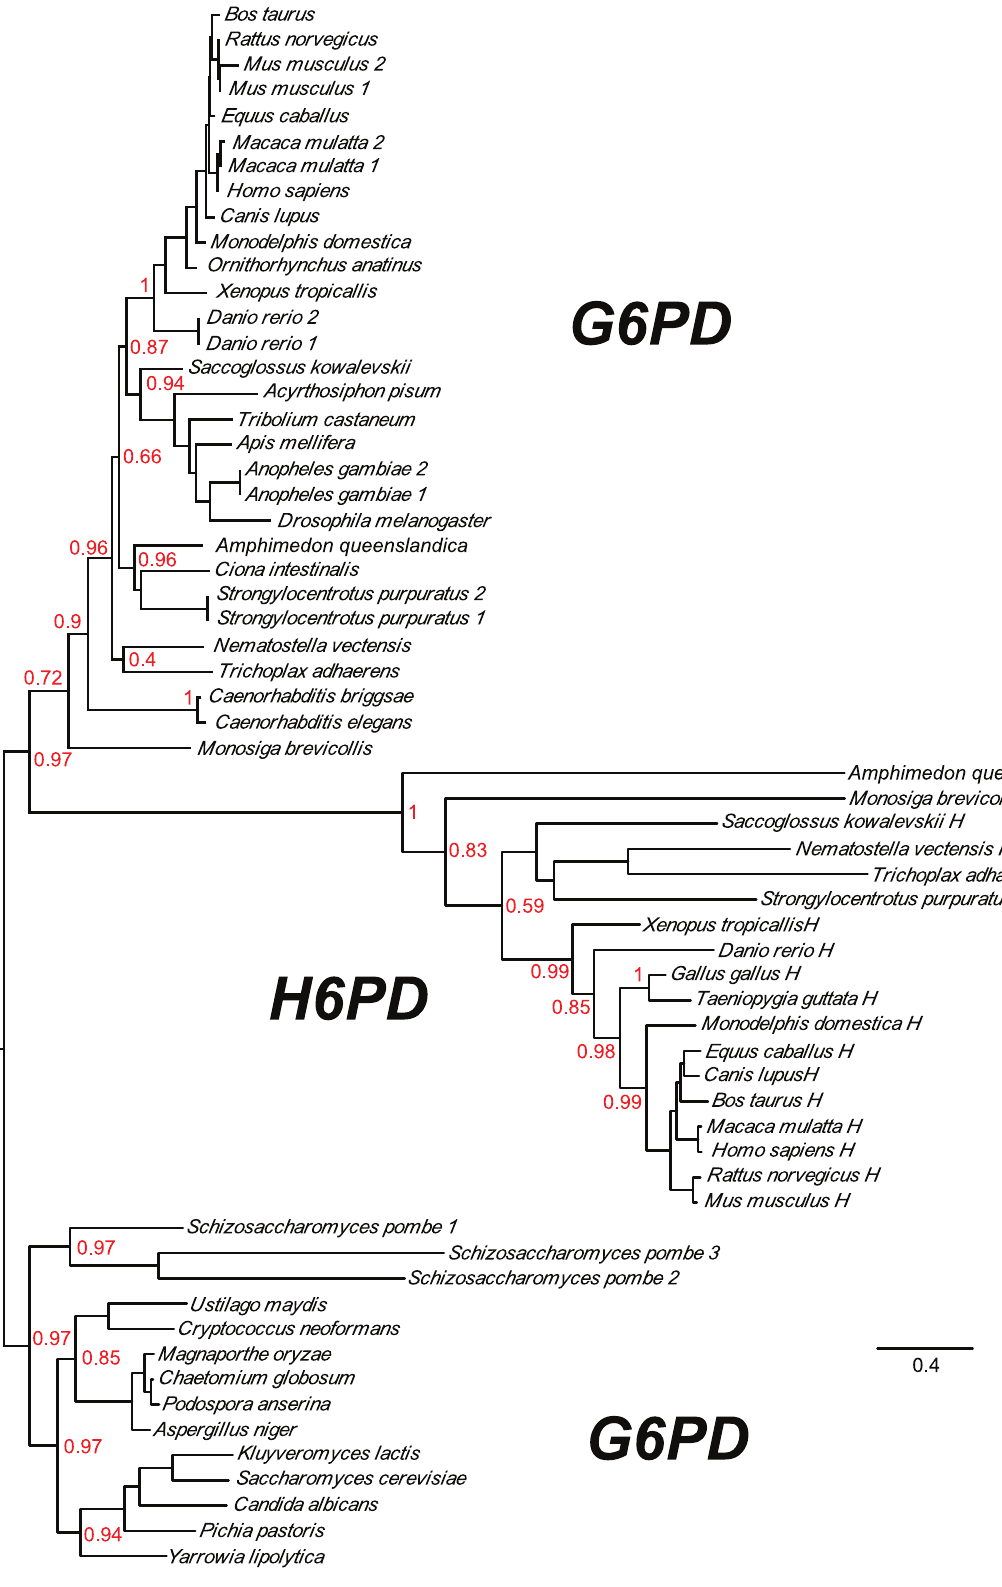
Figure 7. Maximum likelihood tree of Opisthokont G6PD and H6PD proteins. All G6PD sequences are non-fused. Fungi are used as an outgroup for choanoflagellates and metazoans and possess only G6PD orthologs. Both metazoans and choanoflagellates have H6PD genes in addition to G6PD orthologs, both of which were produced by a duplication of G6PD in an ancestor to these groups. All H6PD sequences (labeled with